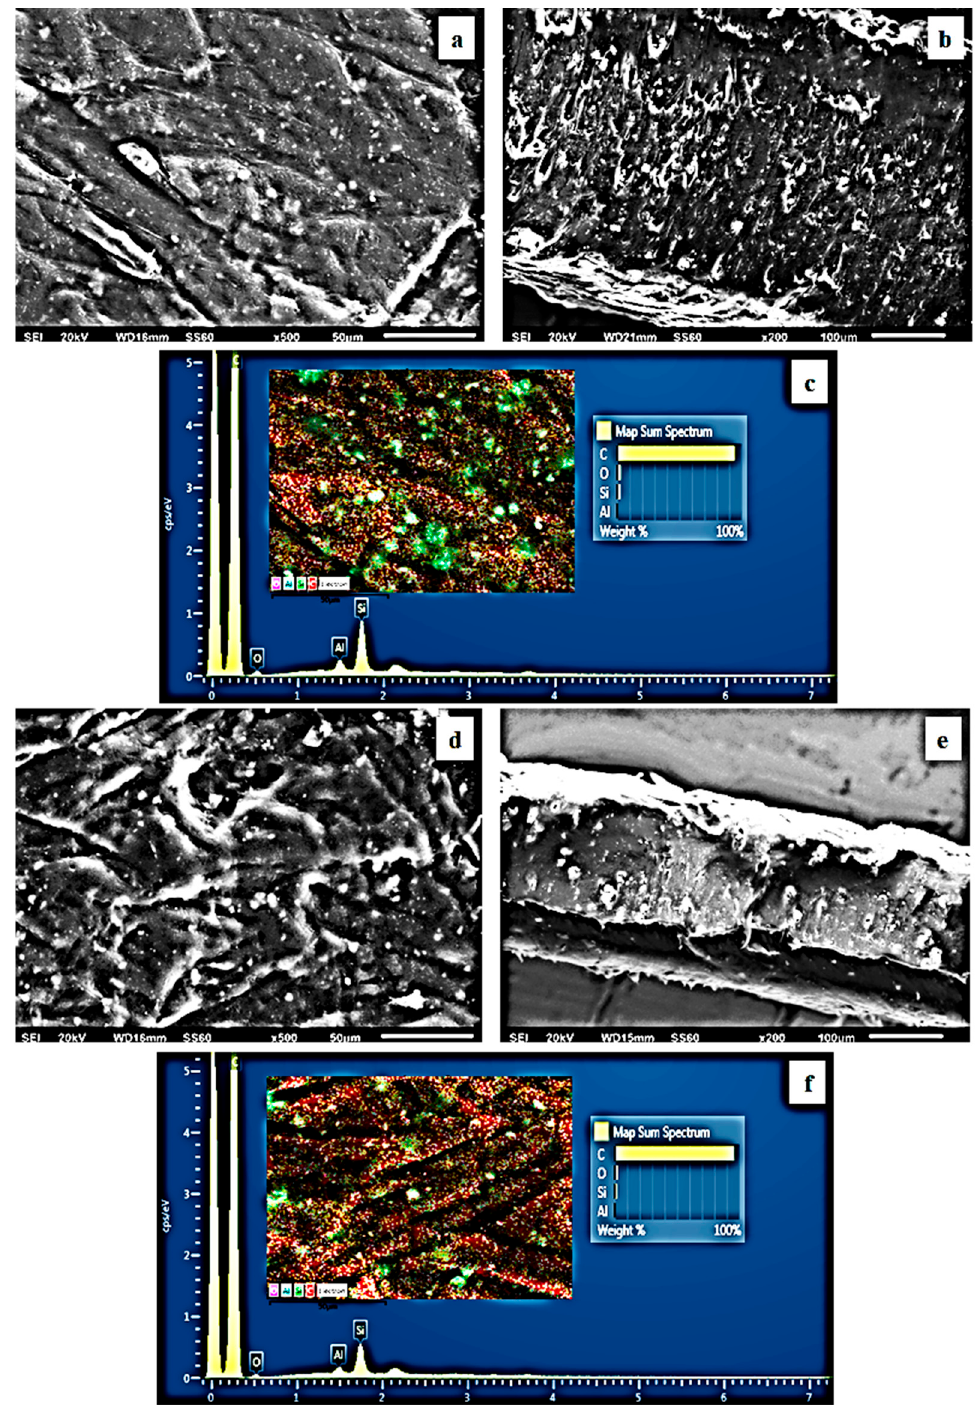
Figure 6. ( a , d ) SEM images of surface and ( b , e ) cross-section of the nanocomposite films of LDPE/10NZ ( a , b ) and LDPE/10TO@NZ ( d , e ), respectively. ( c , f ) Energy-dispersive spectrometer (EDS) spectra, relative elemental analysis, and mapping of the surface from the SEM images at ×1000 magnification.